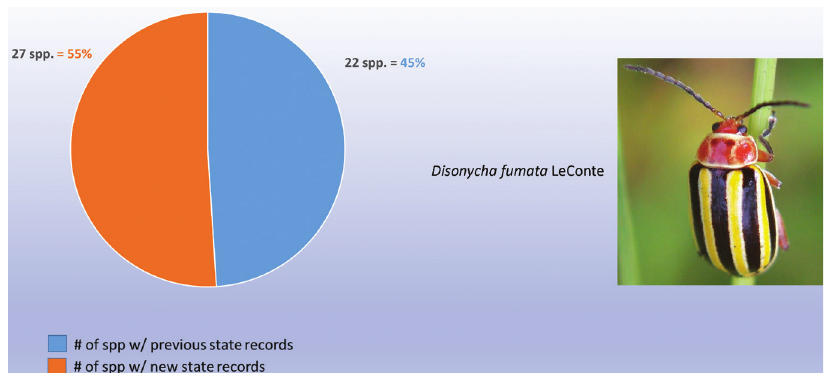
Figure 4. Disonycha Chevrolat new state records versus previously recorded state records.